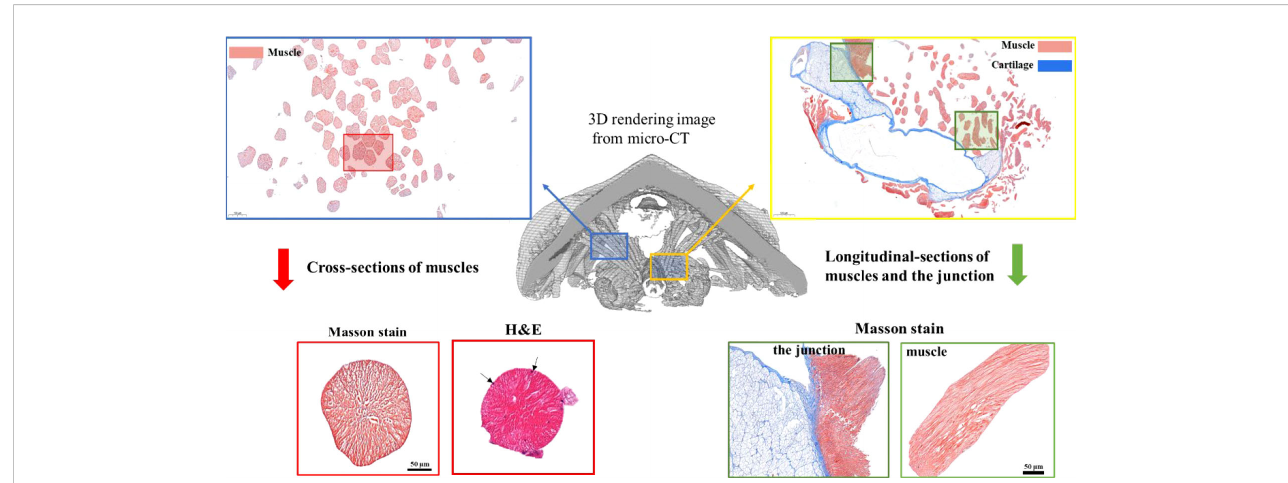
FIGURE 4 Masson staining of radular muscles and their surrounding tissues. The middle is the 3D rendering micro-CT image. The upper left and the lower left is the cross-section of muscle fi bers and one of the magni fi cations. The upper right and the lower right are the longitudinal sections of muscle fi bers and the junction regions between the muscle and the supporting cartilage. For the cross-sectional sections of muscles, both Masson staining and H&E staining were shown. Black arrows indicated multiple cell nuclei.